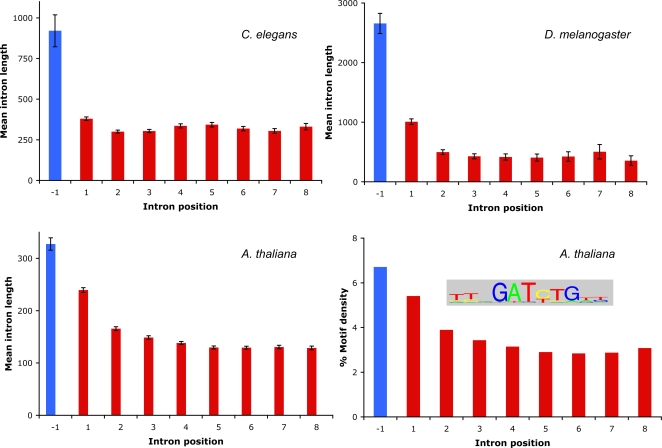
Intron length variation in three model organisms.Mean intron length is calculated for the first intron in the 5′ UTR (position −1, in blue) and for the first eight introns of the coding sequence (in red) for three named species. Error bars indicate standard error of the mean. Bottom right panel shows the occurrence of a potential IME motif (pictured) in A. thaliana introns. %Motif density is calculated by concatenating together all introns in each category, and then calculating what fraction of the total sequence is occupied by the motif.